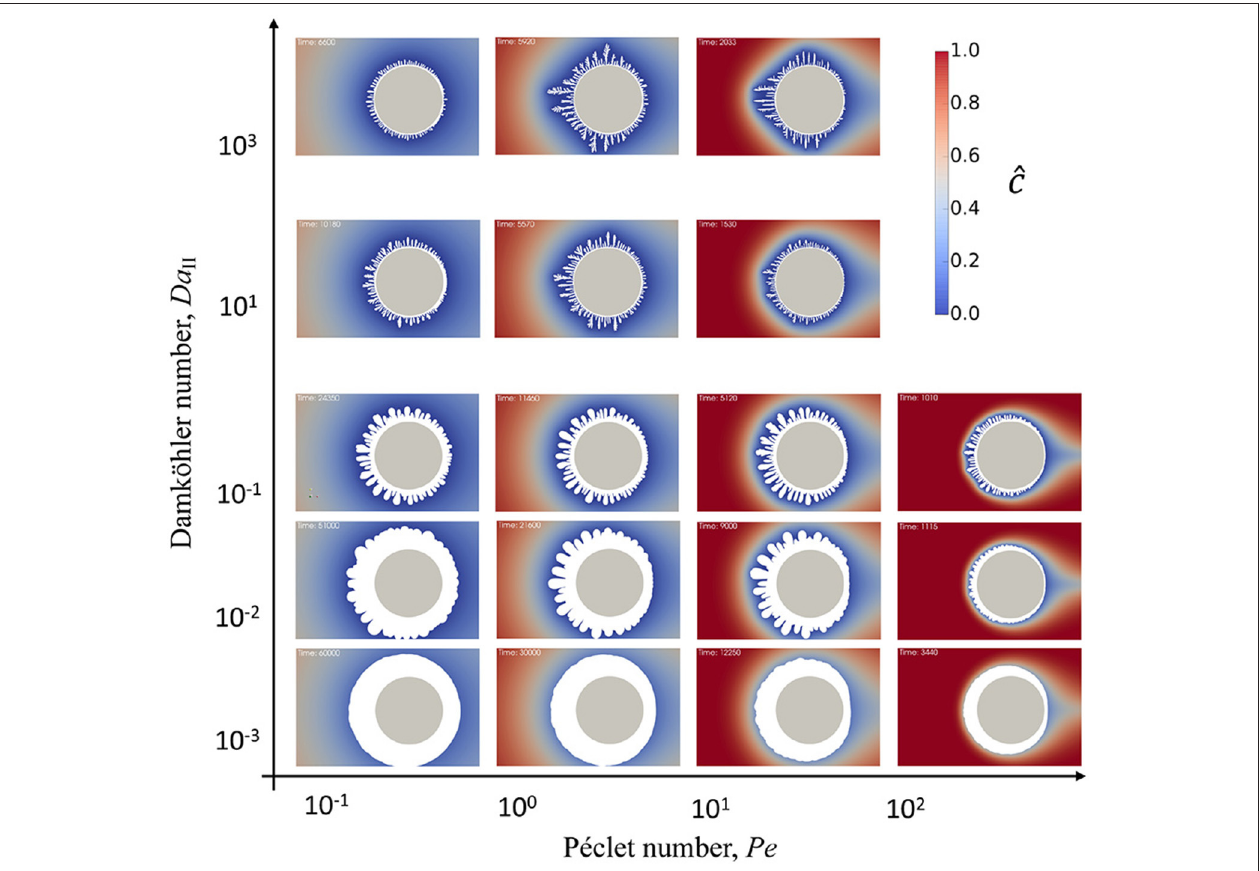
FIGURE 3 | Second Damköhler number, Da II , vs. Péclet number, Pe , phase diagram of precipitation patterns on a particle in reactive flow. The initial particle is shown in gray, precipitate is shown in white, and blue-to-red color scheme shows distribution of reactive species in solution around the particle and solid precipitate.